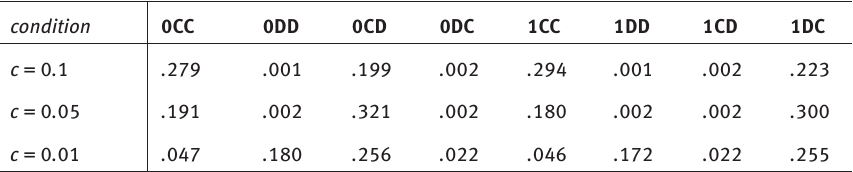
Table 5: The mean population proportions for each strategy in 1000 simulations averaged across the first 100,000 genera- tions. ρ = 200. Populations were initialized drawing a random integer from 1-10 as the initial population of each strategy type. Results are rounded to the nearest